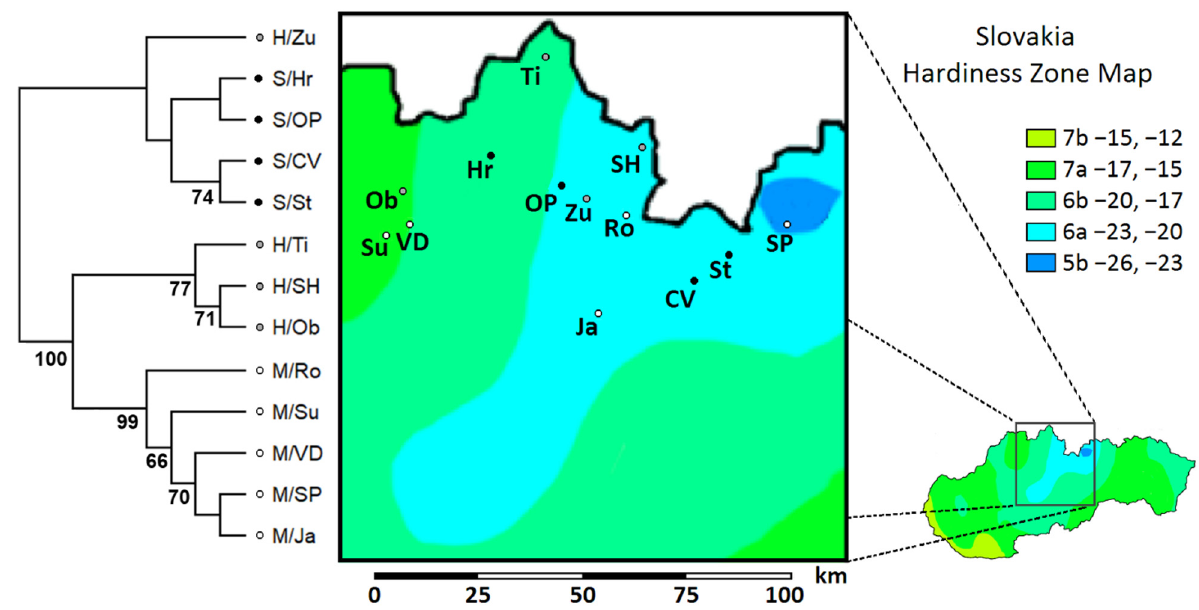
Figure 4. UPGMA distance phenogram illustrating genetic similarity among Slovak populations of P. sylvestris , P. mugo , and their putative hybrids swarms in 80 polymorphic iPBS loci. Bootstrap sup ‐ port >50% is shown. (Pop. abbreviations in Table 1; map adapted from: <https://commons.wiki ‐ media.org/wiki/File:Slovakia_Hardiness_Zones.png#filelinks>, accessed on 17 October 2021, Li ‐ cense: <https://creativecommons.org/licenses/by ‐ sa/4.0>).